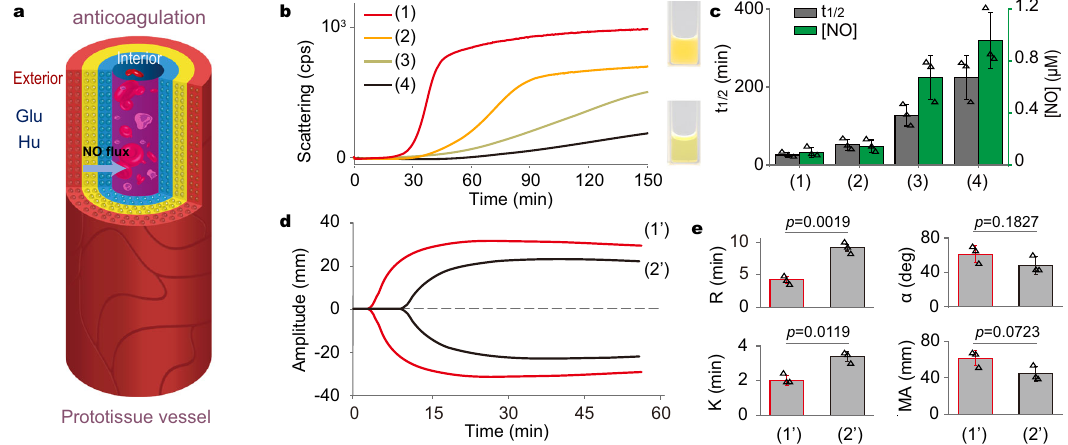
Fig. 5 | Anti-coagulation activity in NO-producing model prototissues. a Graphic of the model prototissue vessel used for the NO fl ux-mediated antic- oagulation ofplasmaor blood samples placed in the central lumen. Populations of GOx-CVs, HRP-CVs or CAT-CVs are immobilized in the outer, middle or inner hydrogel modules, respectively. Glucose (Glu) and hydroxyurea (Hu) are added to the exterior side of the vessel. b Representative plots showing real-time light scattering (counts per second) of blood plasma anticoagulation in the central lumen of the prototissue-like vessel after exposure to a NO fl ux for different time intervals; (1) no exposure (control, red line), (2, orange) 50min, (3, Khaki) 100min and(4,black)150min,showing increasing levelsof anti-coagulation(reduced light scattering). Coagulation is activated upon addition of CaCl 2 (0.02molL − 1 ) after exposure to NO in lumen. Inset; photographs of the plasma in cuvettes for the controlsample(1)andafter150mininthemodelprototissue(4). c Plotsofhalf-life